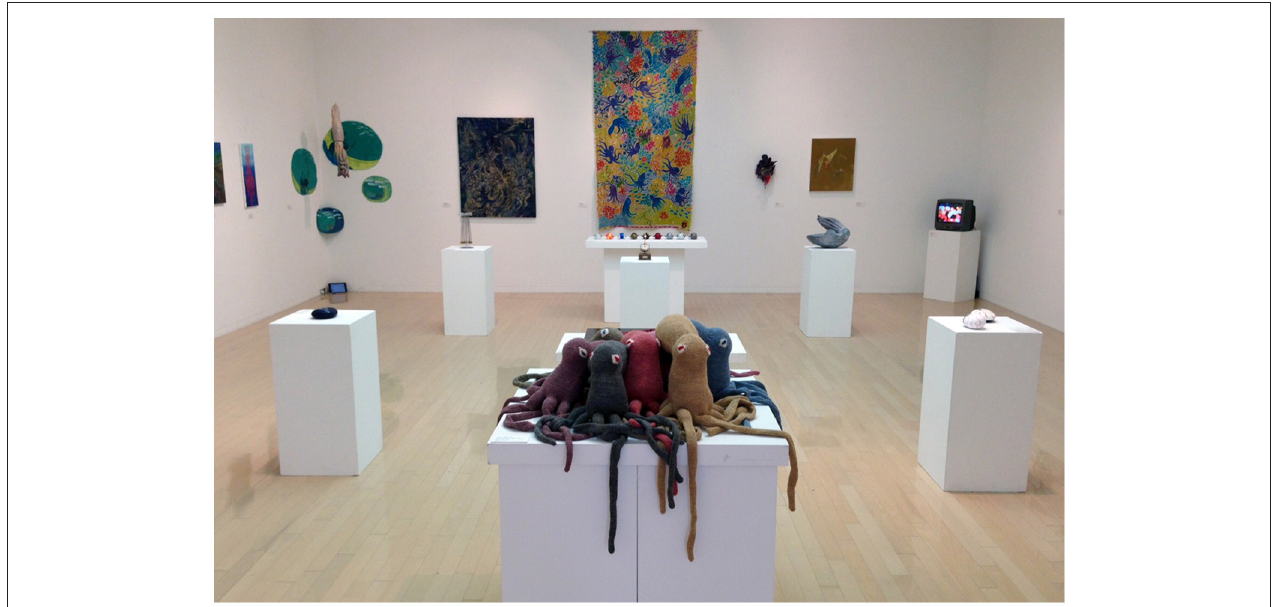
FIGURE 7 | A cephalopod themed art exhibition Cephalopod Interface was organized at the Okinawa Prefectural Art Museum in conjunction with an interdisciplinary cephalopod symposium held at the same location (photographs by R. Nakajima).